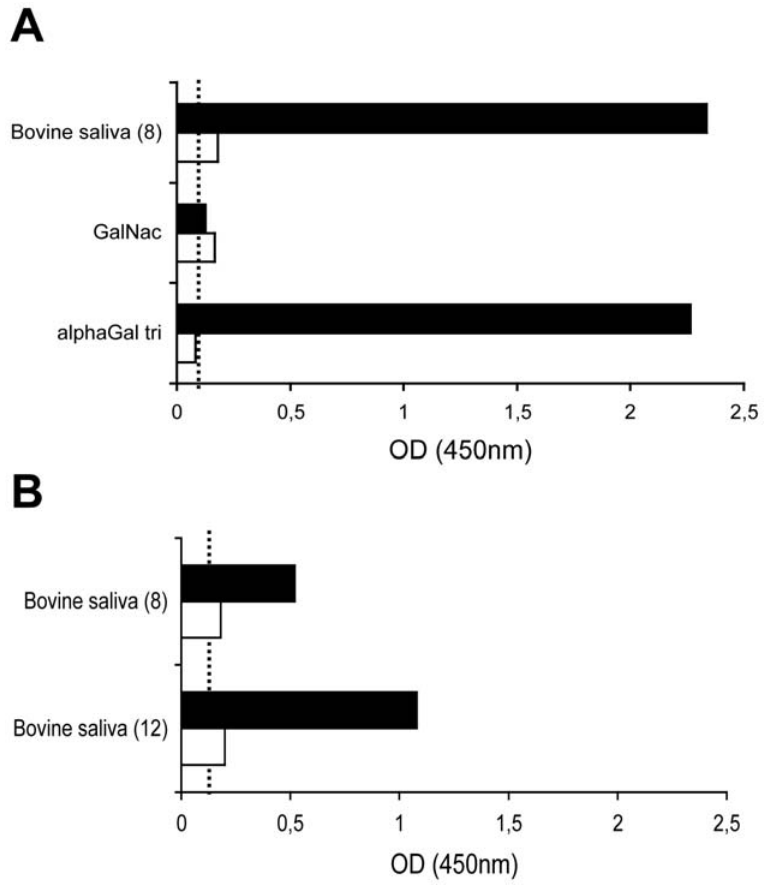
Figure 5. Inhibition of binding to bovine saliva by a -galactosidase treatment or by human natural anti- a Gal antibodies. (A) Bovine saliva from a positive individual ( # 8) or PAA-conjugates ( a Gal trisaccharide and a GalNAc, see Table 1 for structures) were coated at a 1/1000 dilution or 10 m g/ml respectively and either treated with a –galactosidase from green coffee beans (white bars) or enzyme buffer only (black bars). (B) Bovine saliva from 2 positive individuals ( # 8 and # 12) were coated as above and incubated with purified human anti- a Gal (white bars) or blocking buffer only (black bars) for 2 hours prior to addition of rNB2 VLPs. Binding of VLPs was detected as described in the Materials and Methods section and shown as OD 450 nm values. Dashed lines indicate background